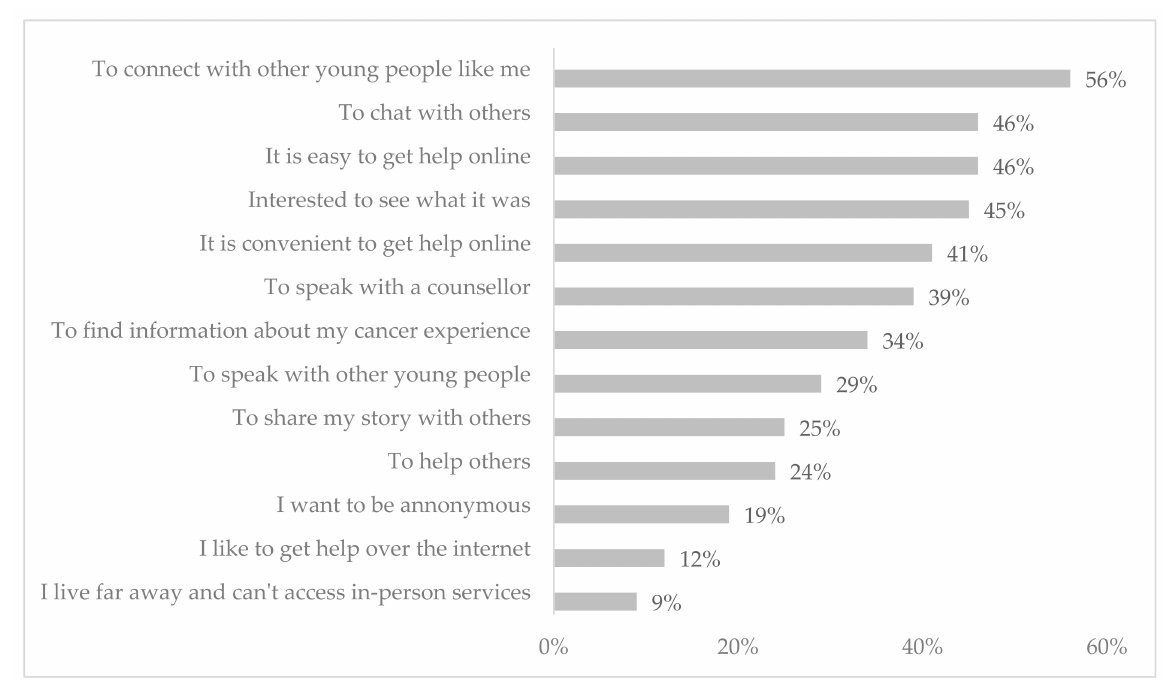
Figure 2. Reasons for joining Canteen Connect version